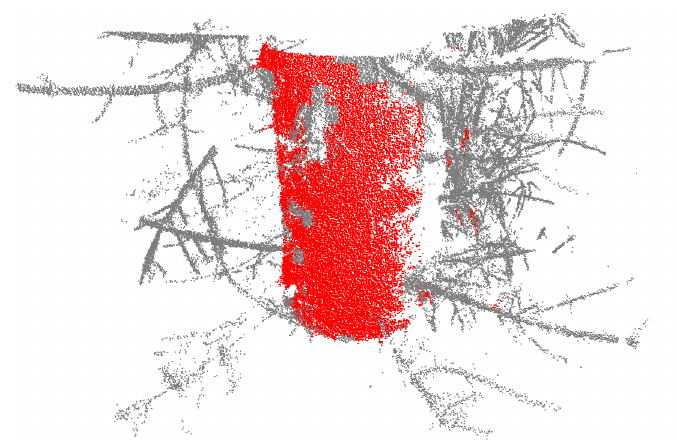
Figure 5. Lidar data points of a tree with a diameter at breast height of 26.35 cm cut out from 1.05–1.55 m above the ground. The data points in this example are filtered with a cluster weight of 15 and a curve weight of 0.75. The grid cell size is 3 × 3 × 3 cm 3 . The red data points have values above the threshold and are used when cylinder fitting the